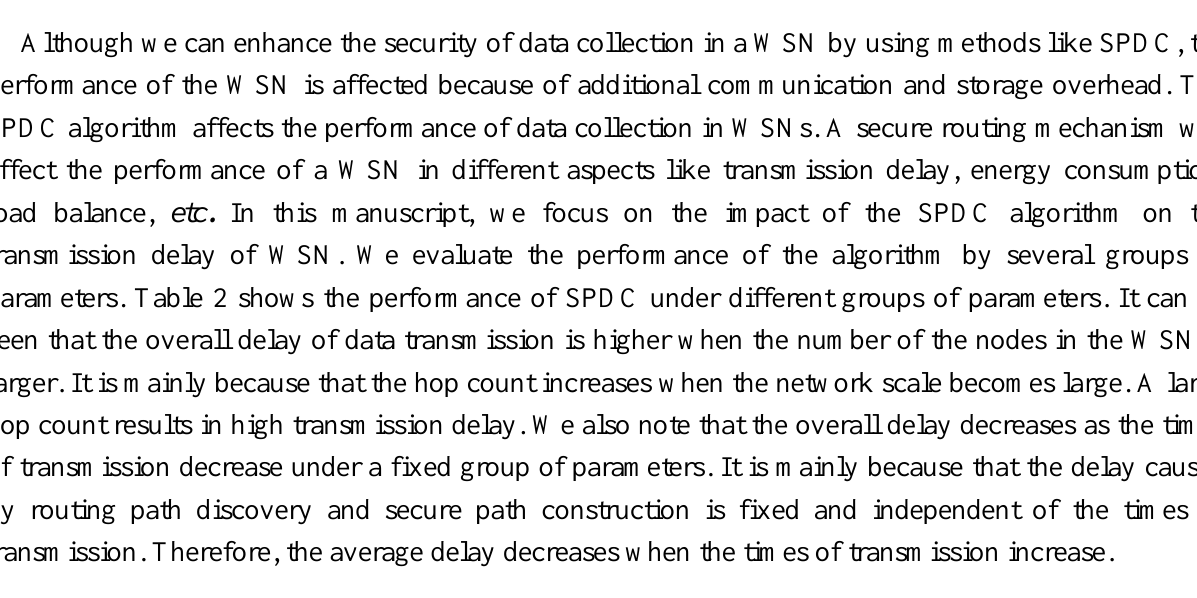
Table 2. The transmission delay of SPDC under different groups of